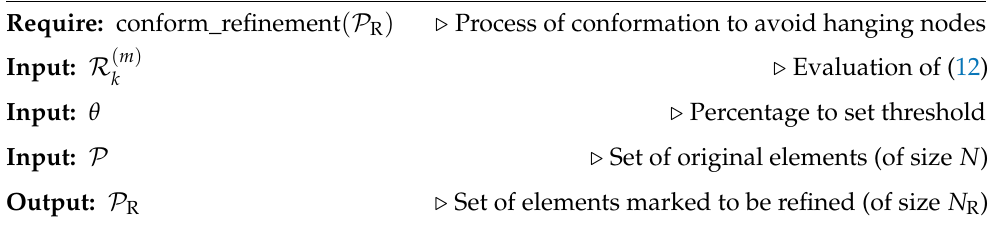
Algorithm 3 Maximum marking